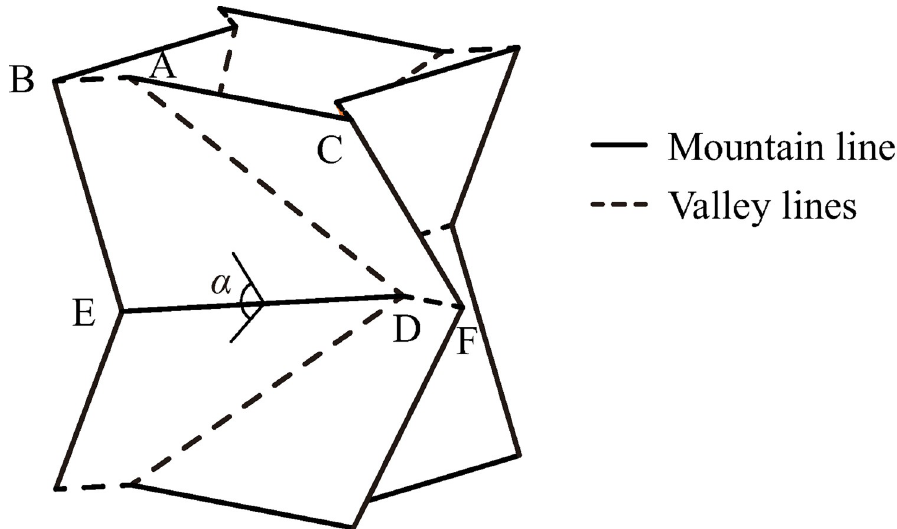
Fig 2. A unit of a curved Miura origami-patterned